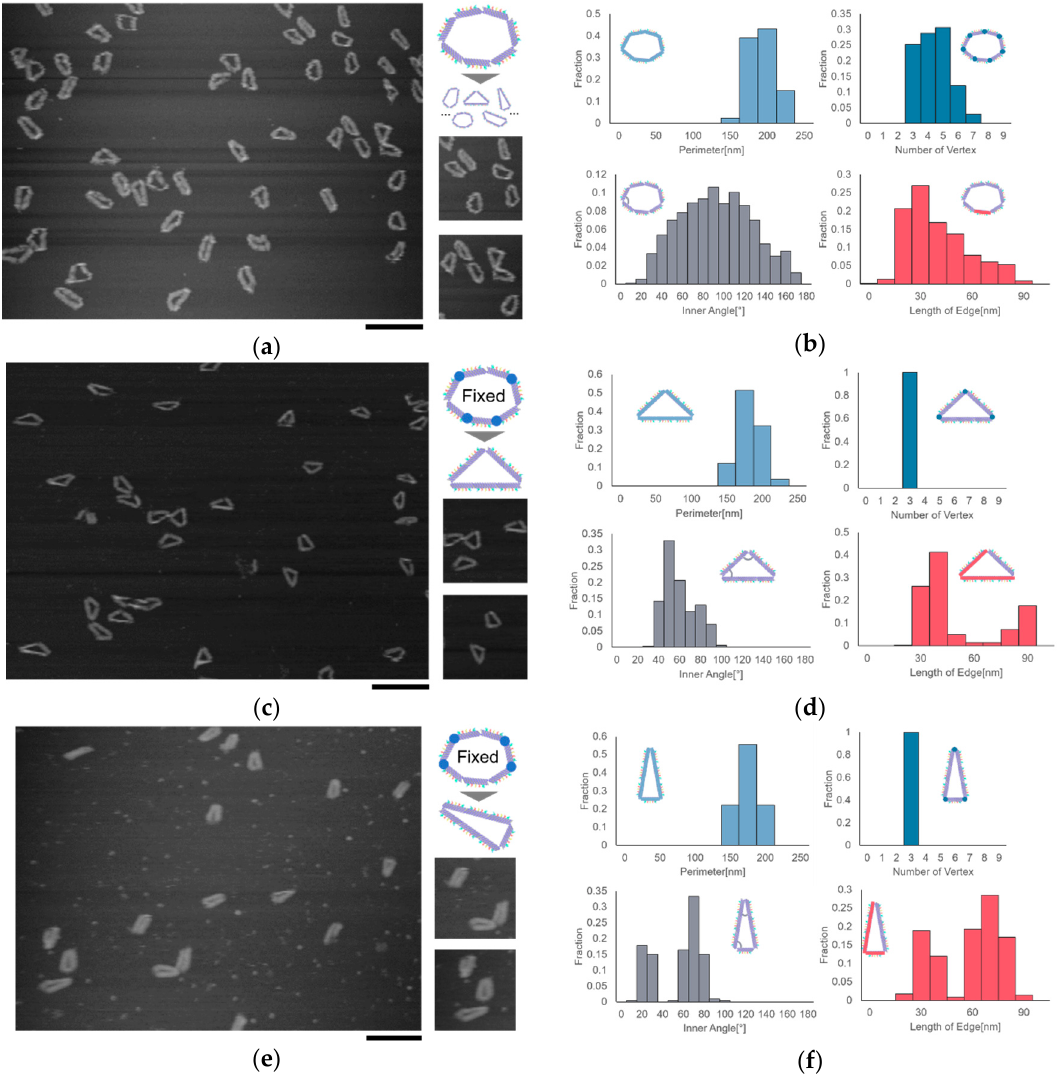
Figure 2. Formation and shape control of the DNA ring motif. ( a ) AFM image of the DNA ring motif in heptagonal shape. Scale bar = 200 nm; ( b ) Analysis result of the heptagonal motif; ( c ) AFM image of Triangle (2, 2, 3), scale bar = 200 nm; ( d ) Analysis result of Triangle (2, 2, 3); ( e ) AFM image of Triangle (3, 3, 1), scale bar = 200 nm; ( f ) Analysis result of Triangle (3, 3, 1).